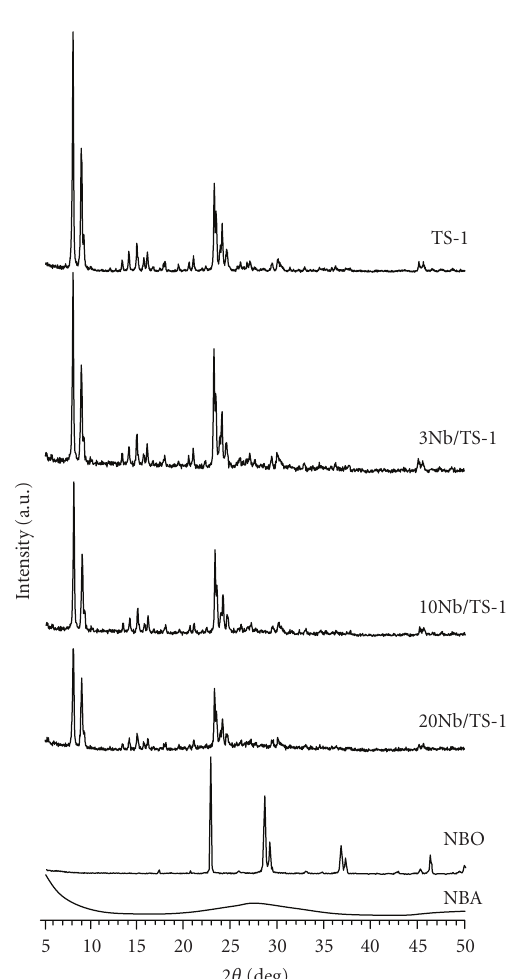
Figure 1: XRD pattern of the NBA, NBO, TS-1, and X Nb/TS-1